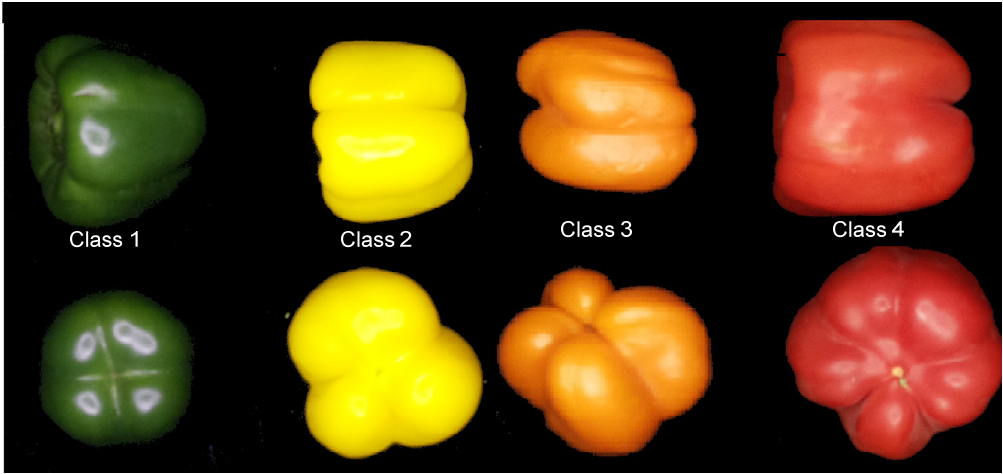
Figure 2. Samples of bell peppers in different degrees of maturity.